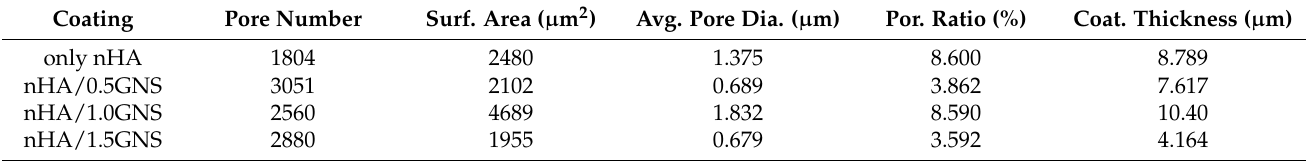
Figure 5. The EDS analysis of PEO treated coatings with ( a ) free GNS, ( b ) 0.5, ( c ) 1.0, and ( d ) 1.5 wt% GNS additive. Table 1. Coating thicknesses, porosity content, and surface areas of coated Ti6Al7Nb substrates with nHA/GNS provided by the PEO